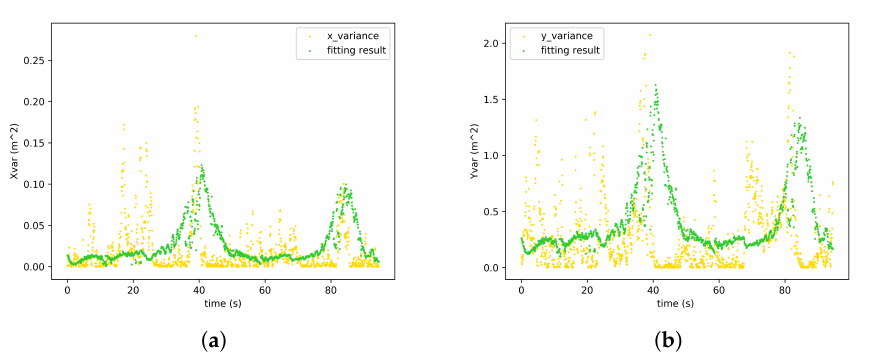
Figure 6. Calibration results for the measurement noise model for monocular 3D localization. ( a ) X varience. ( b ) Y